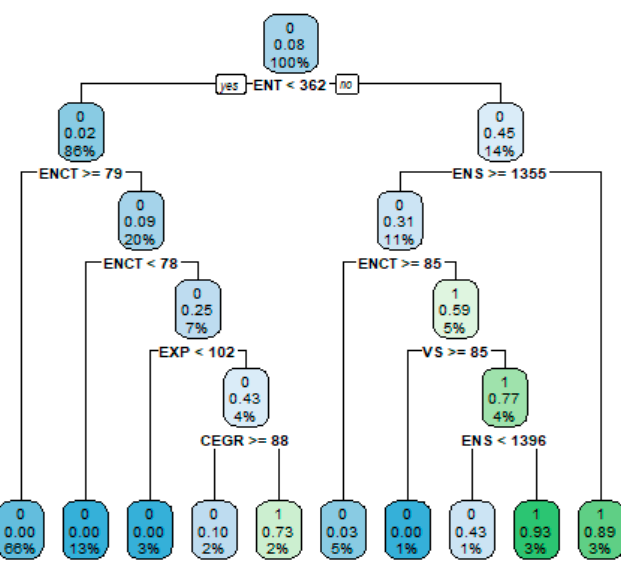
Figure 4. CART generated by a bootstrap sample.